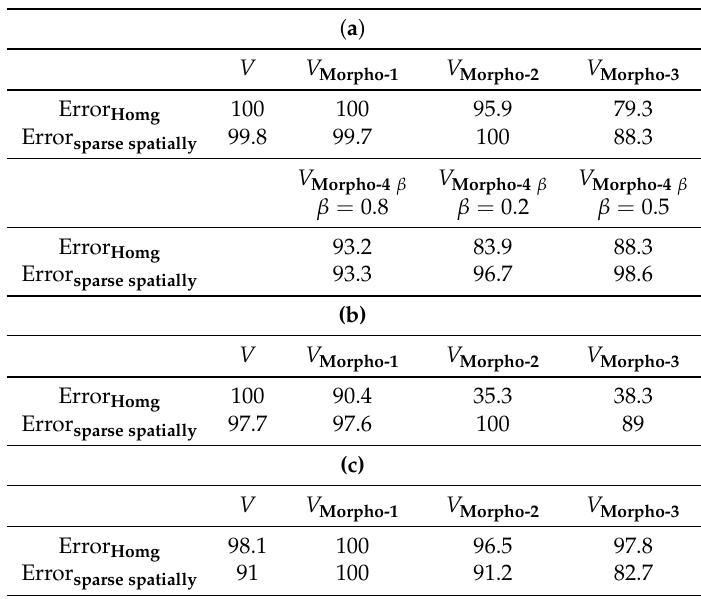
Table 2. Comparison of PCA and MorphPCA analysis using criteria C1 and C2: ( a ) for Pavia hyperspectral image; ( b ) for Houston hyperspectral image; ( c ) for Indian Pines hyperspectral image. The values have been normalized to the worst case, which gives 100.